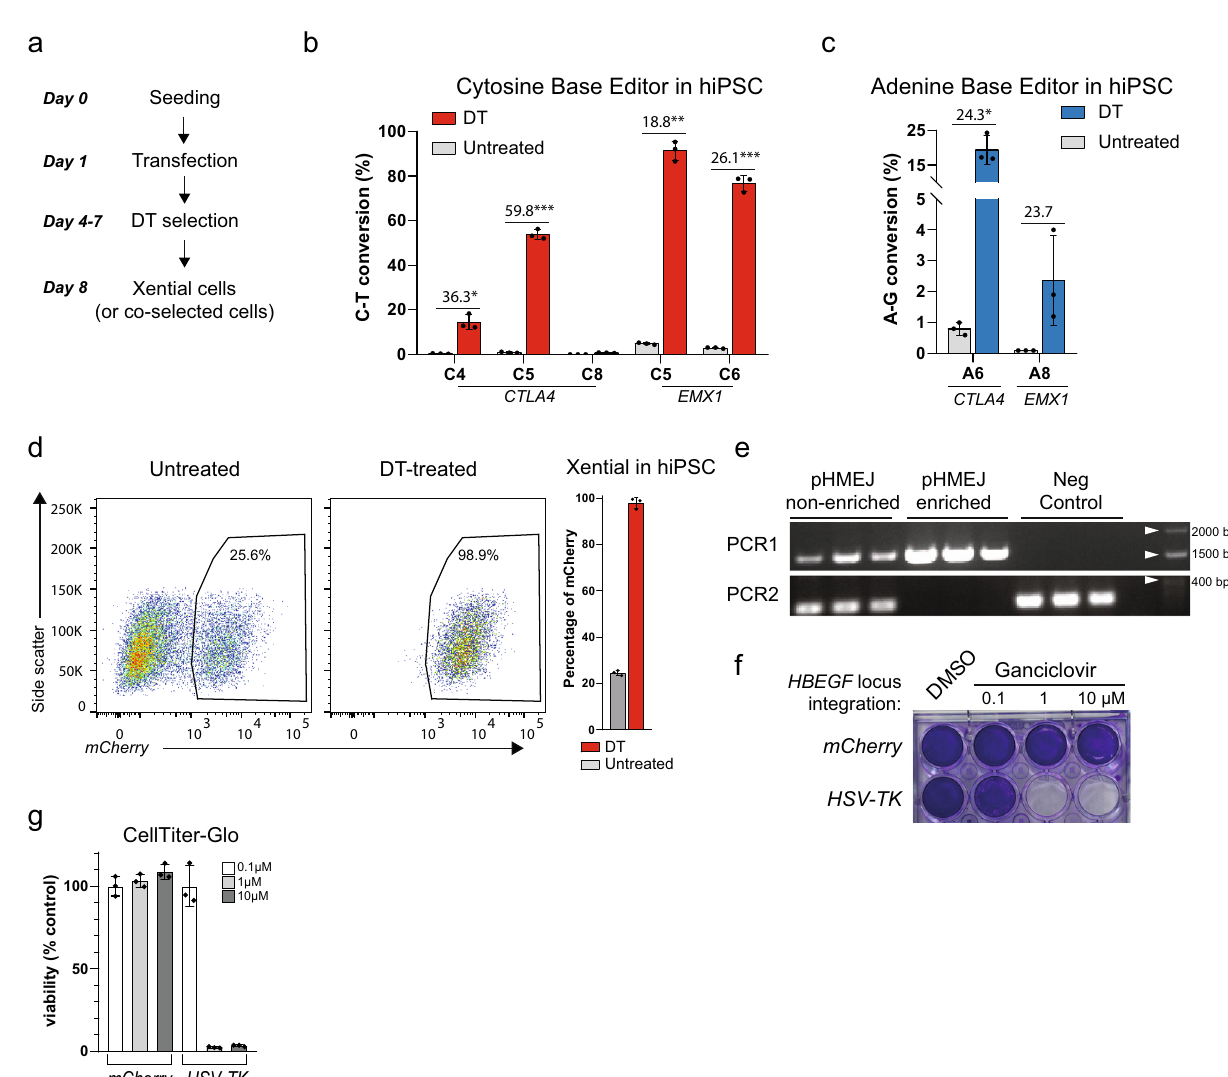
Fig. 5 Enrichment of genome editing events in human iPSCs. a Schema of the experiment timeline. b , c Co-selection of CBE ( b ) and ABE ( c ) editing events in the genome of hiPSCs cultured with or without DT. Analysis of NGS reads showing containing b C – T conversions or c A – G conversions as a percentage of full-length reads from indicated loci using depicted sgRNAs. d Enrichment of knock-in events at HBEGF locus with Xential. The left panel shows the mCherry signal in the fl ow cytometry scatter plots for non-enriched and DT-enriched samples, and the right panel shows the quantitative frequencies of mCherry-positive cells. e PCR analysis of genomic DNA from hiPSCs after Xential. Genotyping at HBEGF intron 3 (see Fig. 3d). Representative results were shown from three independent biological replicates. f – g The HSV-TK gene inserted in the HBEGF locus using Xential renders hiPSCs sensitive to gancivlovir. Crystal violet staining assay ( f ) and CellTiter-Glo assay ( g ) showing viability of cells containing either the mCherry or the HSV-TK gene inserted in the HBEGF locus. Cells were treated with depicted concentration of ganciclovir or DMSO (control) for 3 days followed by a 3-day recovery without the drug. Values and error bars re fl ect mean ± s.d. of n = 3 independent biological replicates. Relative fold changes are indicated in the graphs. * P < 0.05, ** P < 0.01, *** P < 0.001, Student ’ s paired t test (two-tailed). P values are calculated as below: in b , CTLA4 (C4 = 0.0179 and C5 = 0.0007) and EMX1 (C5 = 0.0010 and C6 = 0.0006); in c , CTLA4 (0.0154) and EMX1 (0.1146). Source data of Fig. 5b – e, g are provided as a Source data fi